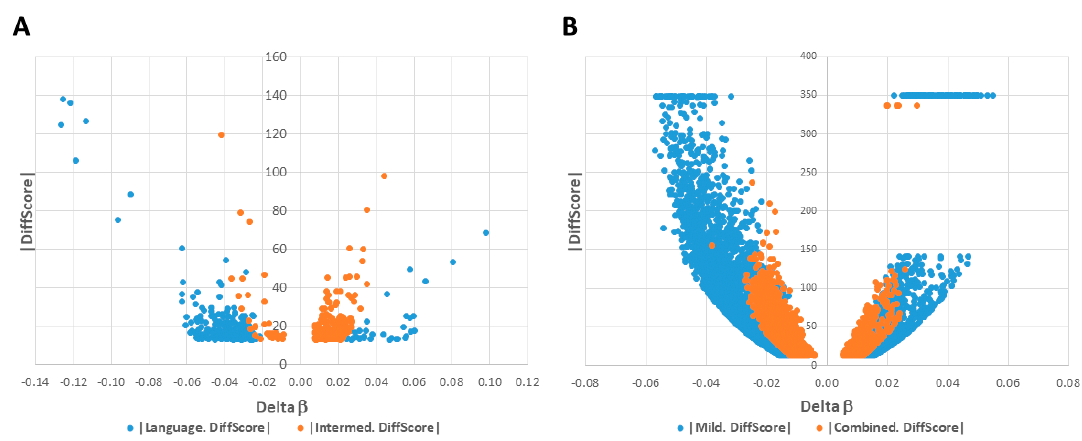
Figure 2. Volcano plots of significant di ff erentially methylated regions and associated genes (DAGs) among subgroups and combined cases. | Di ff Score | versus Delta β plots for significant DAGs in: ( A ) severely language-impaired (blue) and intermediate (red) subgroups; ( B ) mild subgroup (blue) and combined cases (red). Note: A | Di ff Score | of 13 is roughly equivalent to a p -value of 0.05.